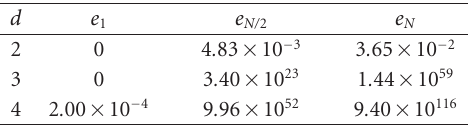
Table 6.9. Approximate error for Example 6.3.